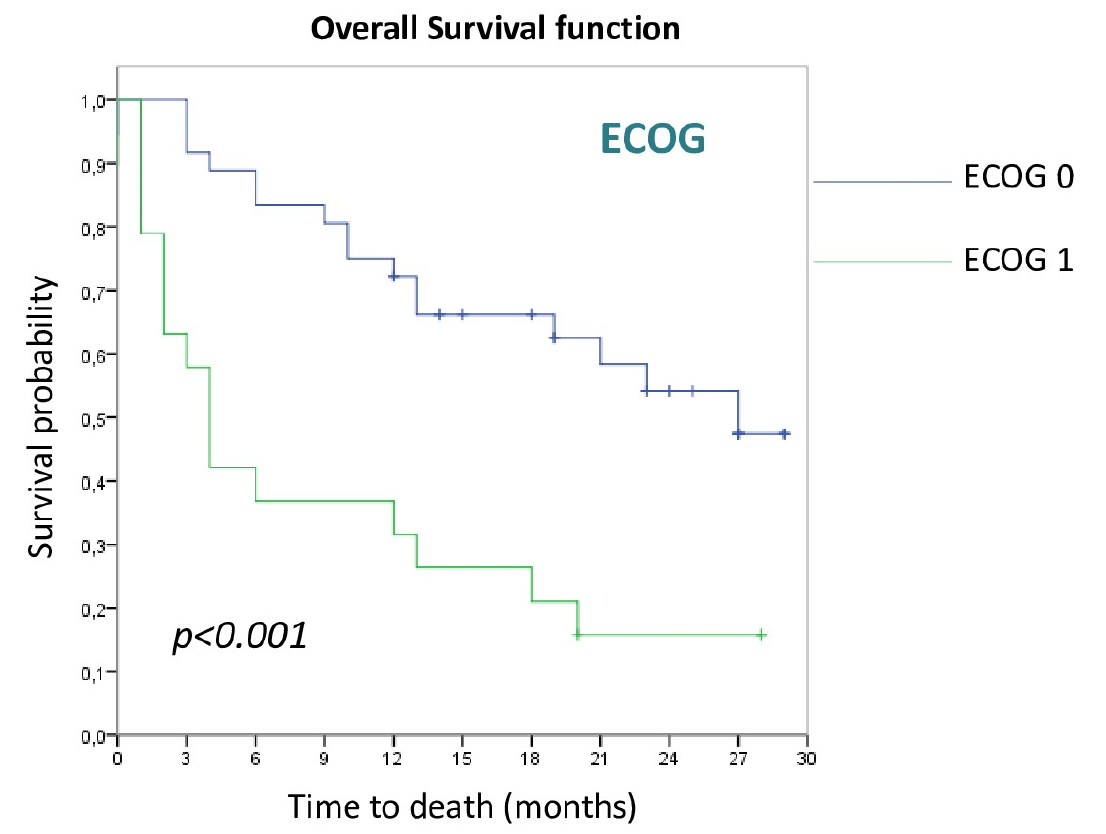
Figure 1. Overall survival curves according to ECOG.